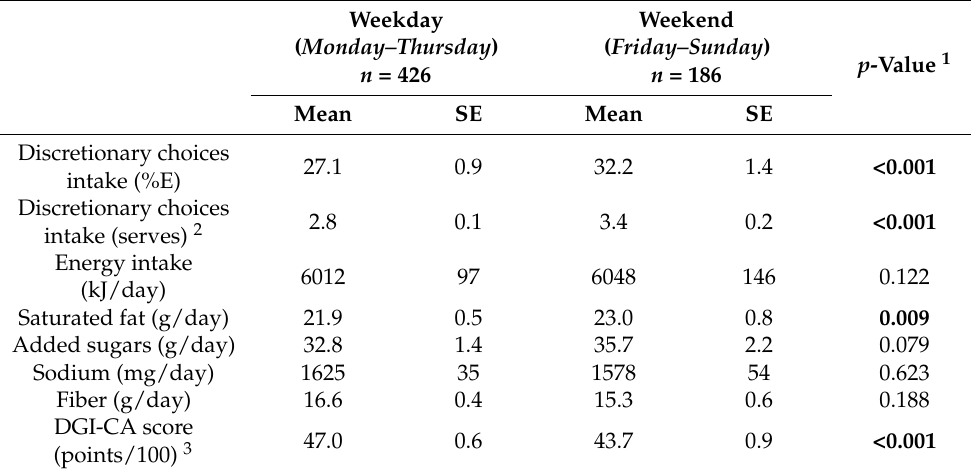
Table 2. Dietary intake of Australian preschool children (2–4 yo) on weekdays (Monday–Thursday) versus weekend days